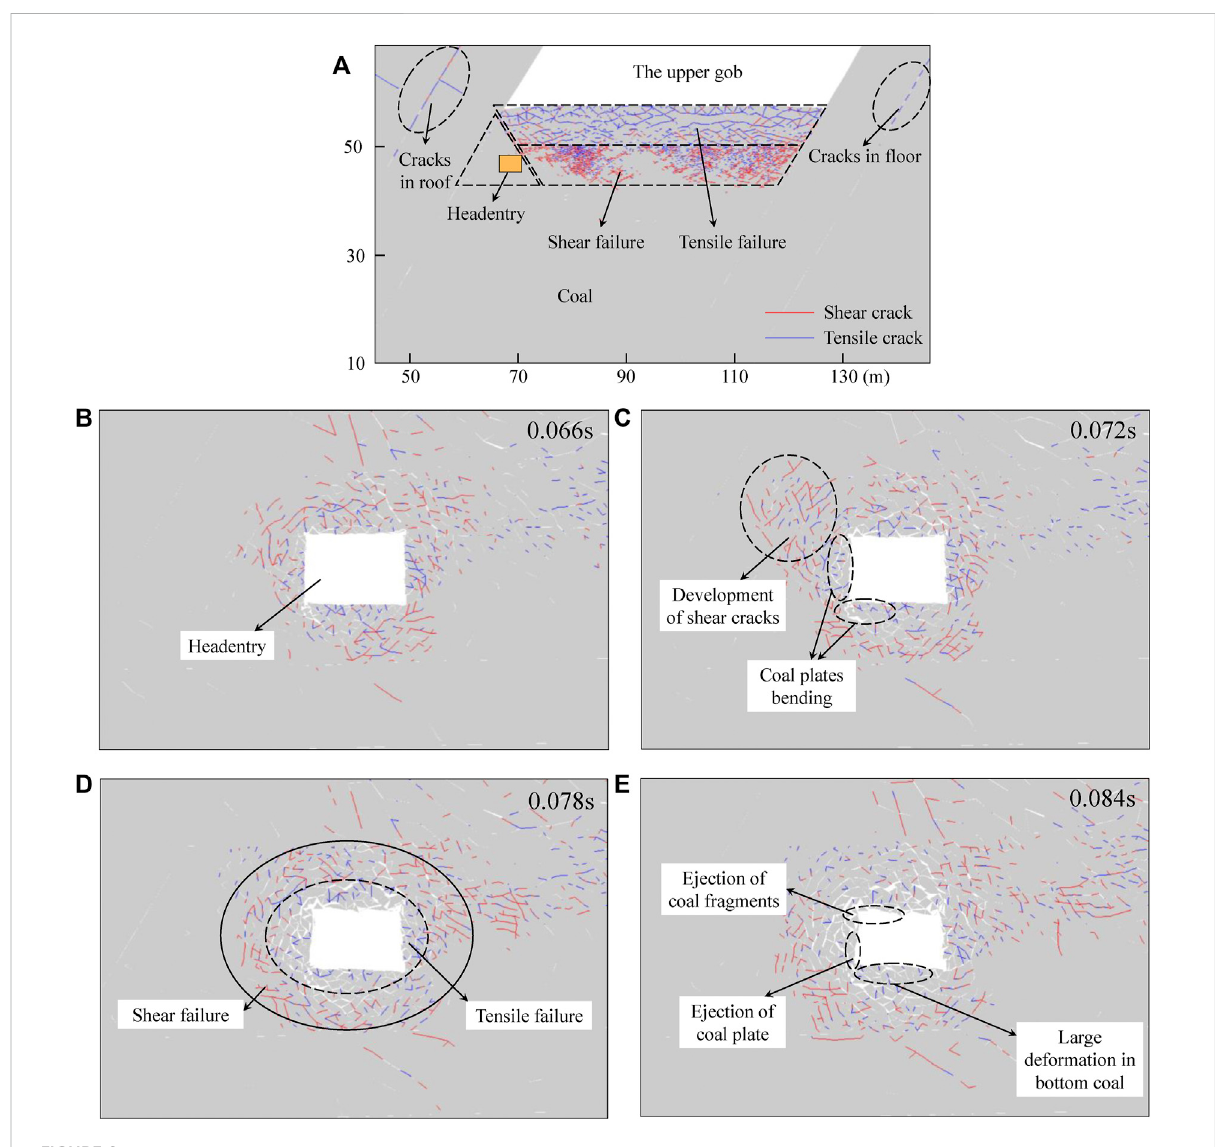
FIGURE 9 Crackdevelopment: (A) thecracksafterminingoftheuppersection, (B) dynamictime is0.066sintheMSTCB, (C) dynamictime is0.072sinthe MSTCB, (D) dynamic time is 0.078s in the MSTCB, and (E) dynamic time is 0.084s in the